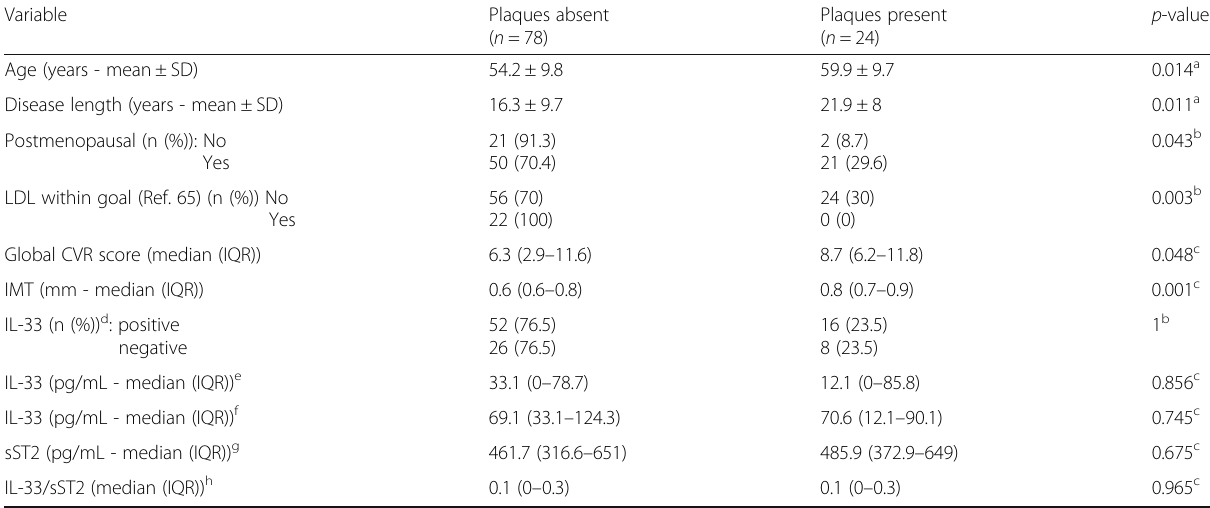
Table 3 Comparison of patients with and without atherosclerotic plaques Variable Plaques absent